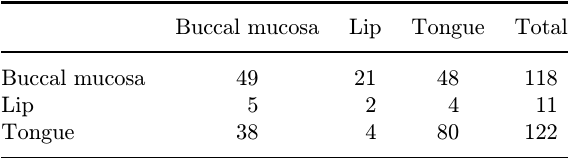
Table 5. PC-LDA for identifying anatomical di®erences at buccal mucosa, lip and tongue subsites in tumor conditions.